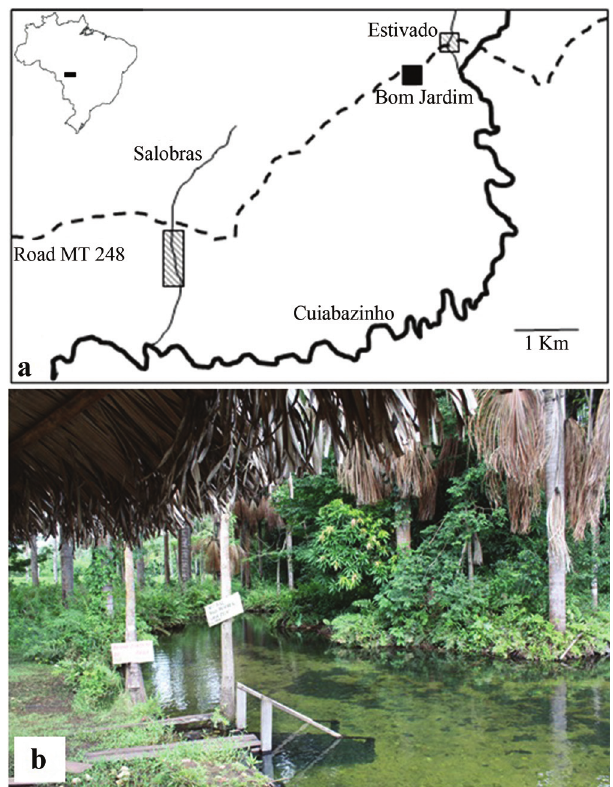
Fig.1. Study area. a ) Detailed map of the study area, black rectangle on the map of Brazil indicates the location of Bom Jardim. Dashed areas indicate the main study area (Estivado River) and a comparison area (Salobra River). b ) Photo of the study site in Estivado River by Eduardo Bessa (December